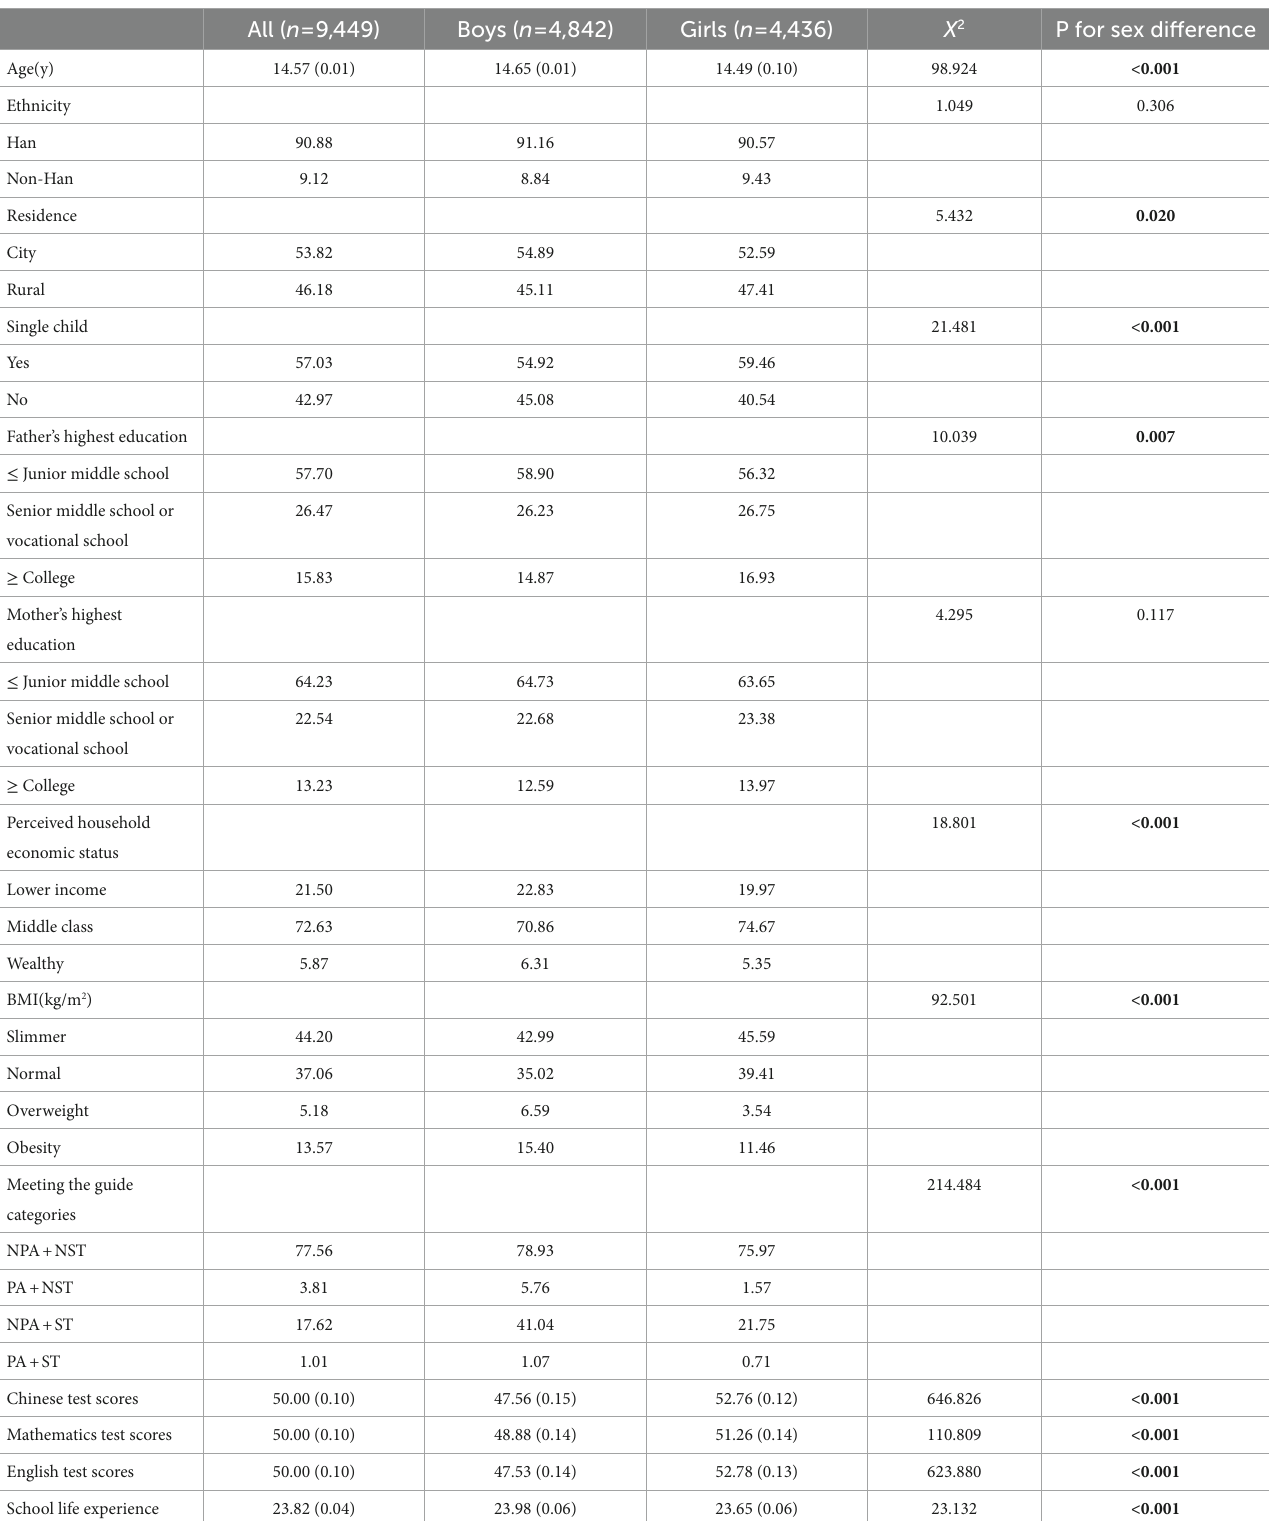
TABLE 1 Characteristics of Chinese adolescents [mean